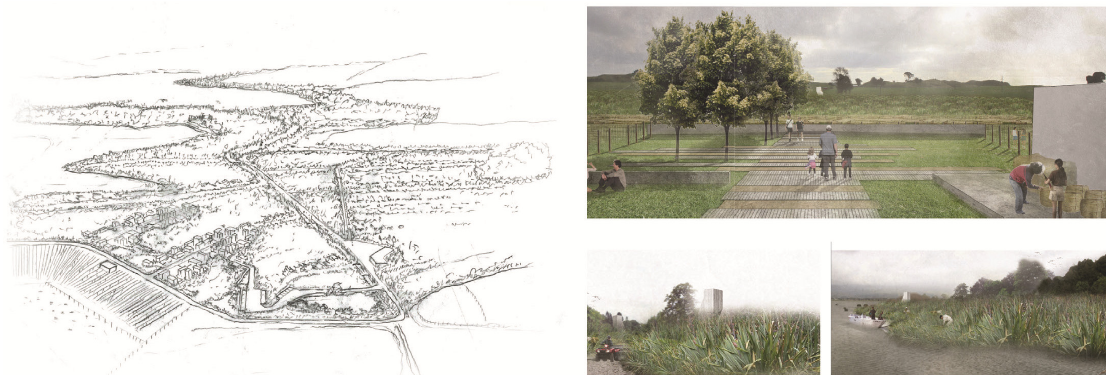
Figure 7. Renovating Rural Living , a speculative design by Nick Wheaton. Left: aerial view of proposed flax producing harekeke that is endemic to wetland edges, replacing dairying. Rural community settlement and production buildings are proposed in the foreground with a road to nearby towns and Wellington. In the background is Lake Horowhenua. Right: images of rural community living that would be integrated with the production. Source: Nick Wheaton .